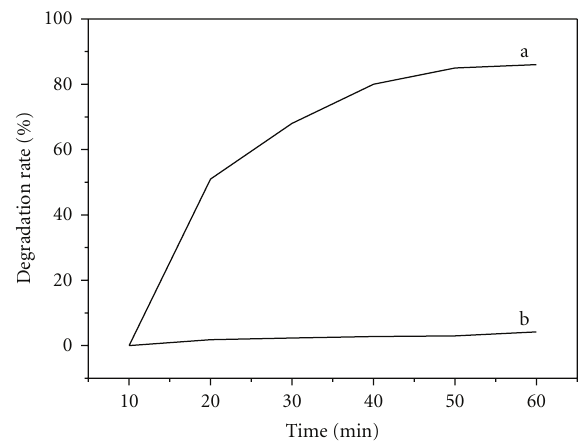
Figure 5: E ff ect of di ff erent concentration of Fe 3 O 4 @Au on deg- radation of 10 − 5 M chloridazon: (a) 10 − 4 M Fe 3 O 4 @Au and (b) 10 − 5 M Fe 3 O 4 @Au.